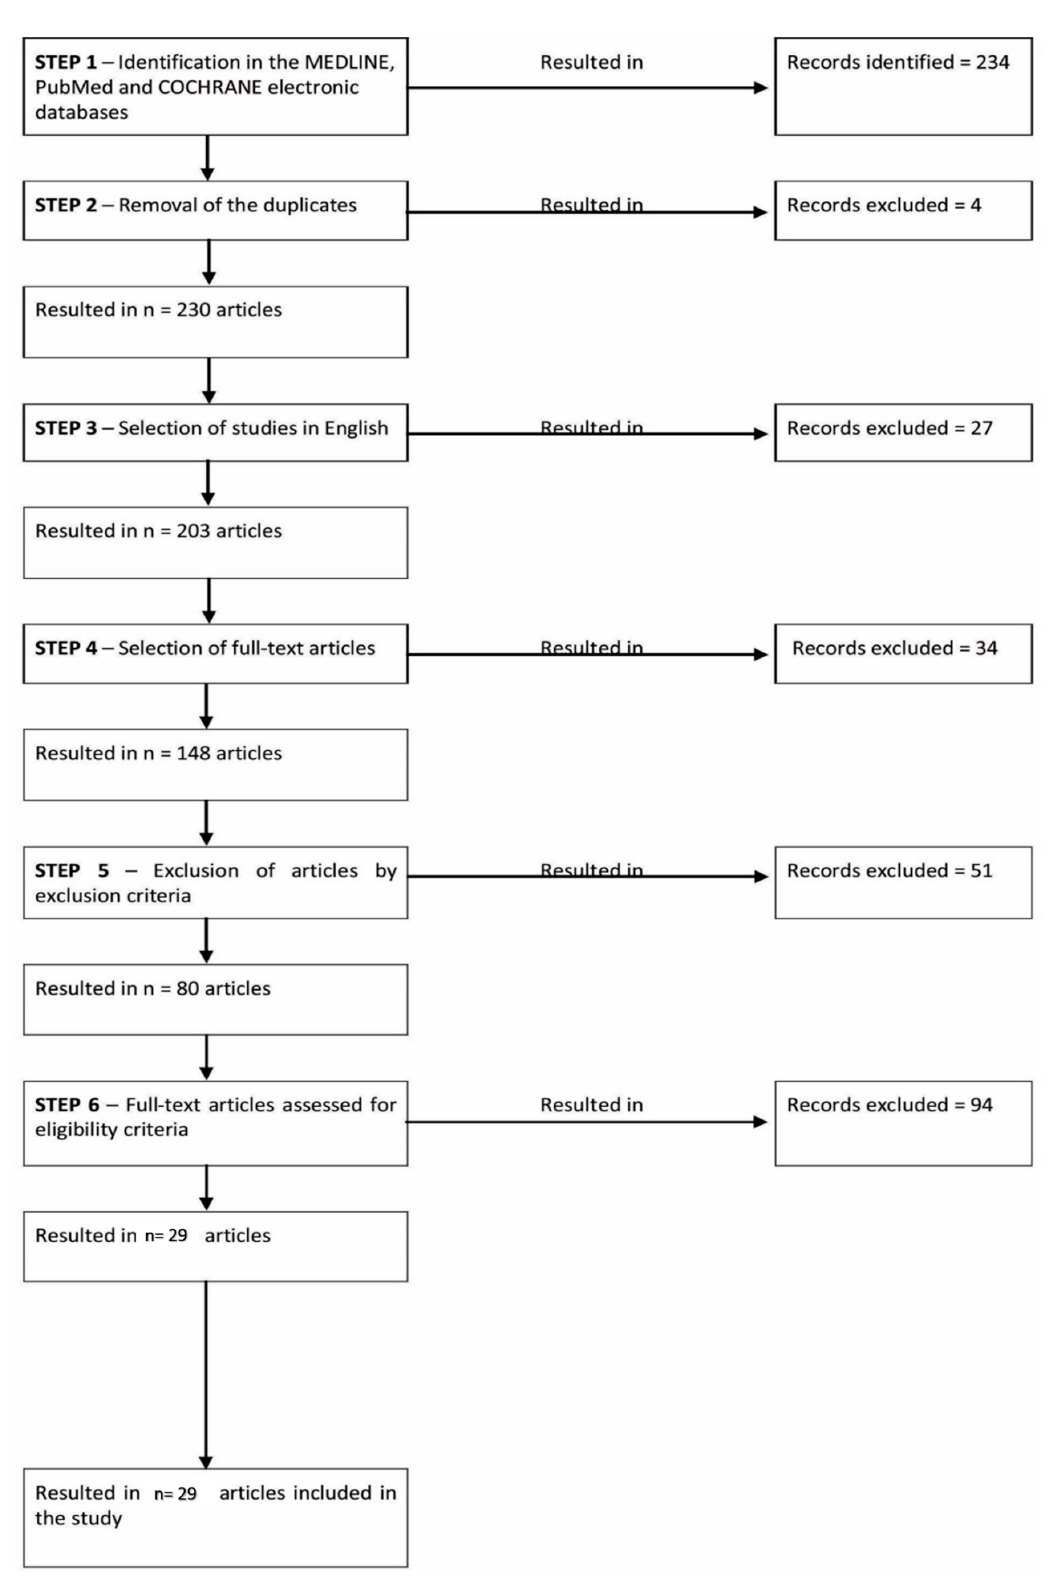
Figure 1. Study screening and selection process .